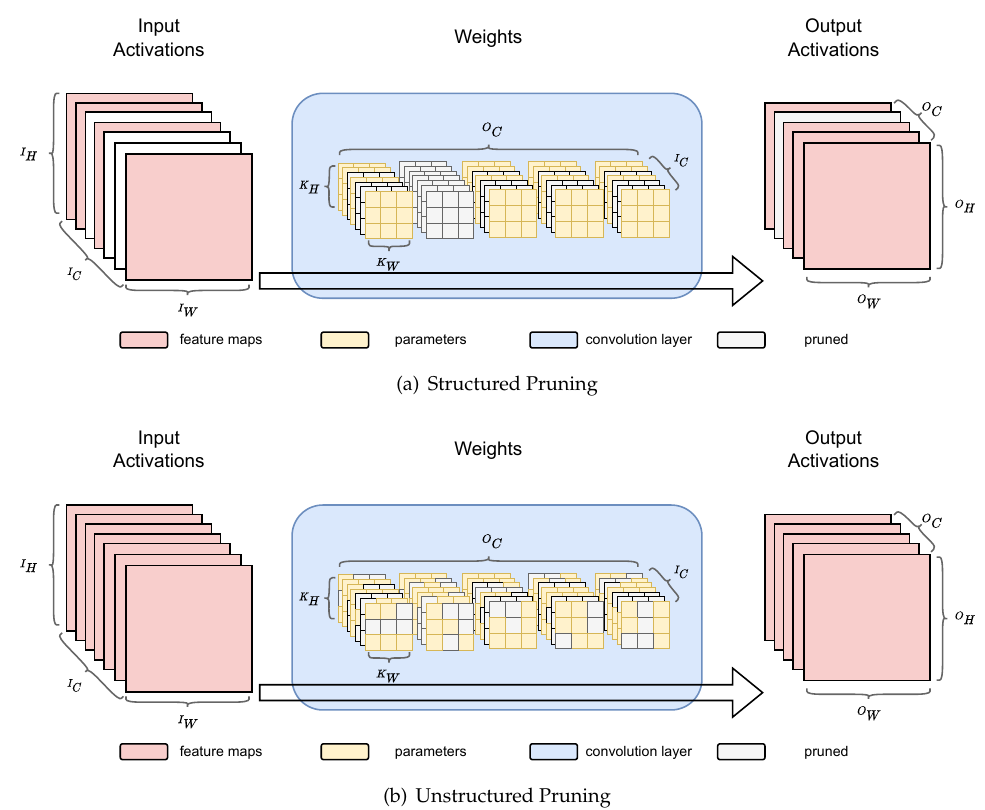
Figure 2. We depict the differences between structured ( a ) structured pruning and ( b ) unstruc- tured